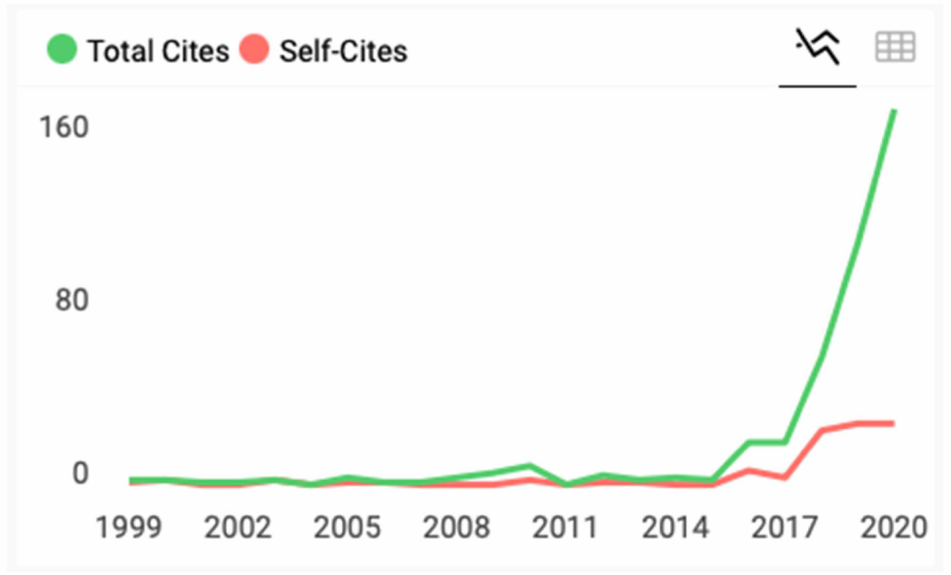
Figure 6. The analysed journal total citations vs. self-citations ratio, where the increasing trend also follows a larger number of published papers per